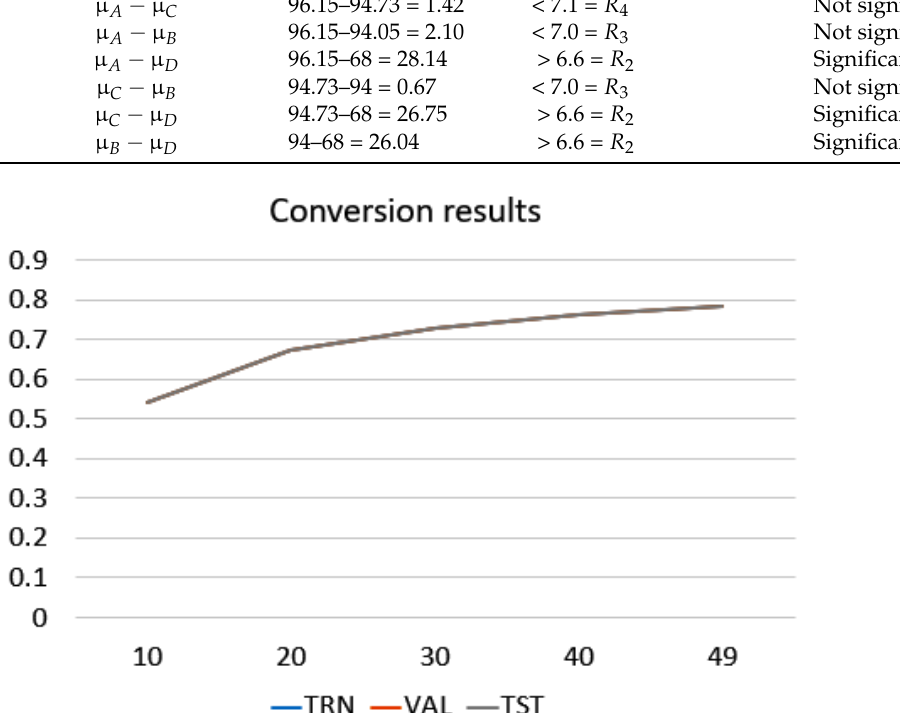
Figure 9. Plot: percentage of classification by selecting a smaller number of features after conversion to sparse matrices.